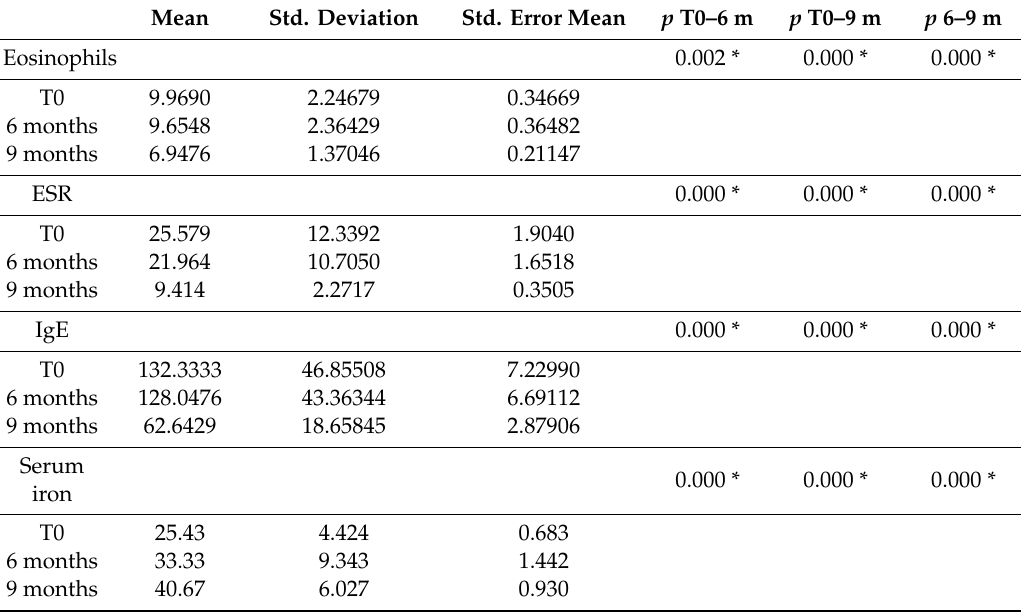
Table 5. Correlation of disease progression in the first subgroup, which received strict diet and lifestyle changes. Mean Std.